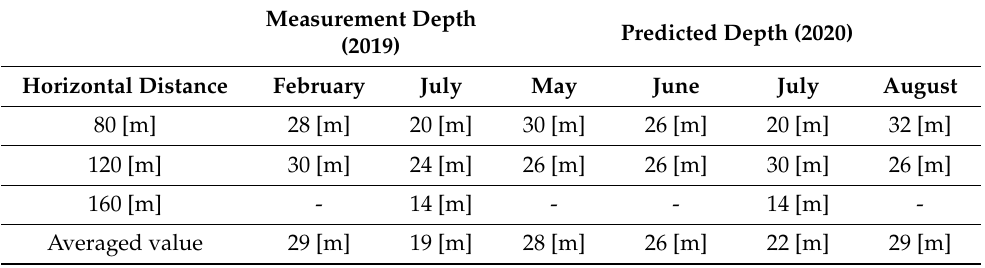
Table 4. Estimated discontinuity depth based on the discontinuity of porosity and hydraulic